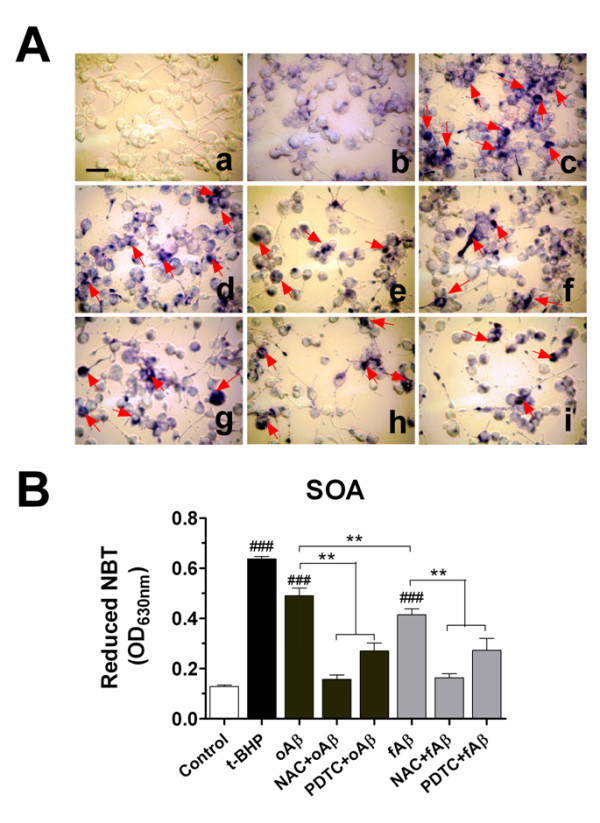
Aβ induced the intracellular level of superoxide anion (SOA) in microglial cells: effects of NAC and PDTC. Nitro blue tetrazolium (NBT) to formazan by superoxide anion (O2-) was used to measure the production of SOA. (A) BV-2 cells were pretreated with NAC (5 mM) or PDTC (20 μM) for 1 h and then stimulated with oligomeric Aβ(1-42) (1.0 μM) or fibrillar Aβ(1-42) (5.0 μM) for 12 h. Treatment of cells with t-BHP (100 μM) alone for 1 h was as a positive model control. Then NBT was incubated for a further 45 min and was fixed with methanol. The cells containing blue formazan particles (NBT-positive cells) were visualized under the microscope. (a): Blank (without NBT incubation); (b): Drug-free groups; (c): t-BHP alone; (d): oAβ alone; (e): NAC+oAβ; (f): PDTC+oAβ; (g): fAβ alone; (h): NAC+fAβ; (i): PDTC+fAβ. Scale bar = 50 μm. (B) NBT depositing inside the cells were dissolved with solubilization solution and the superoxide anion levels were quantified by the absorbance measured on a microplate reader at 630 nm. Each value is expressed as mean ± S.E. ###P < 0.001, compared with the drug-free group. **P < 0.01, compared between groups.